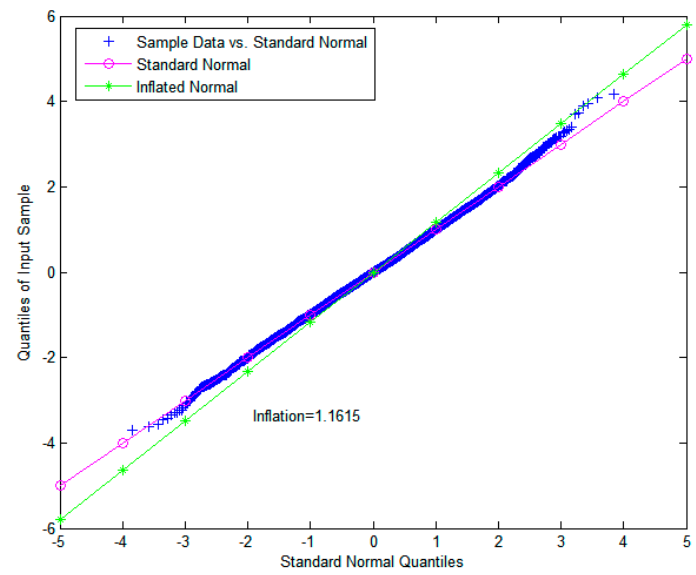
Figure 4. QQ plot for determination of the inflation factor using GPS synthetic data.